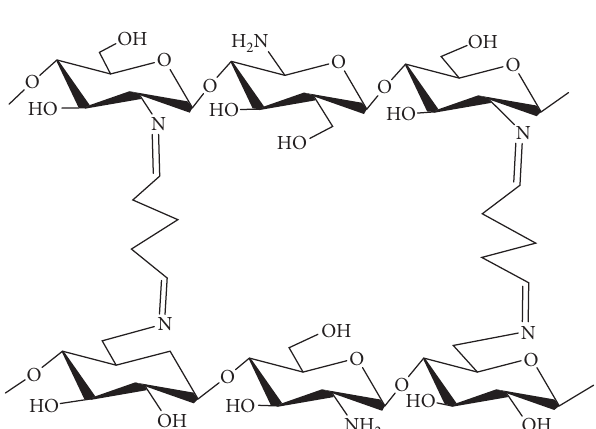
2 O 4 -CS-SO 3 H catalyst [30].